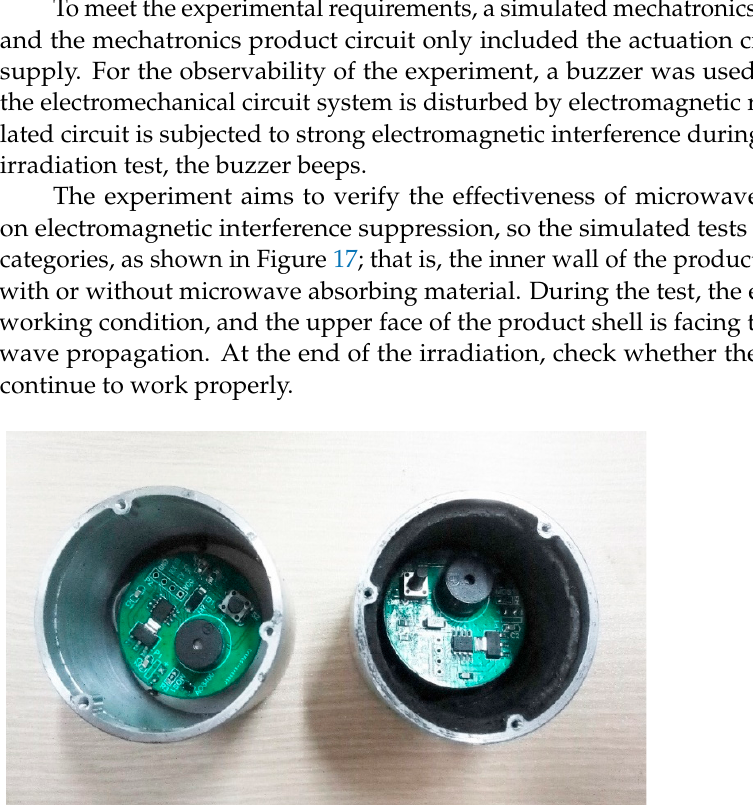
Figure 17. Analog mechatronics product. Without absorbing material ( left ). With absorbing mate- rial ( right